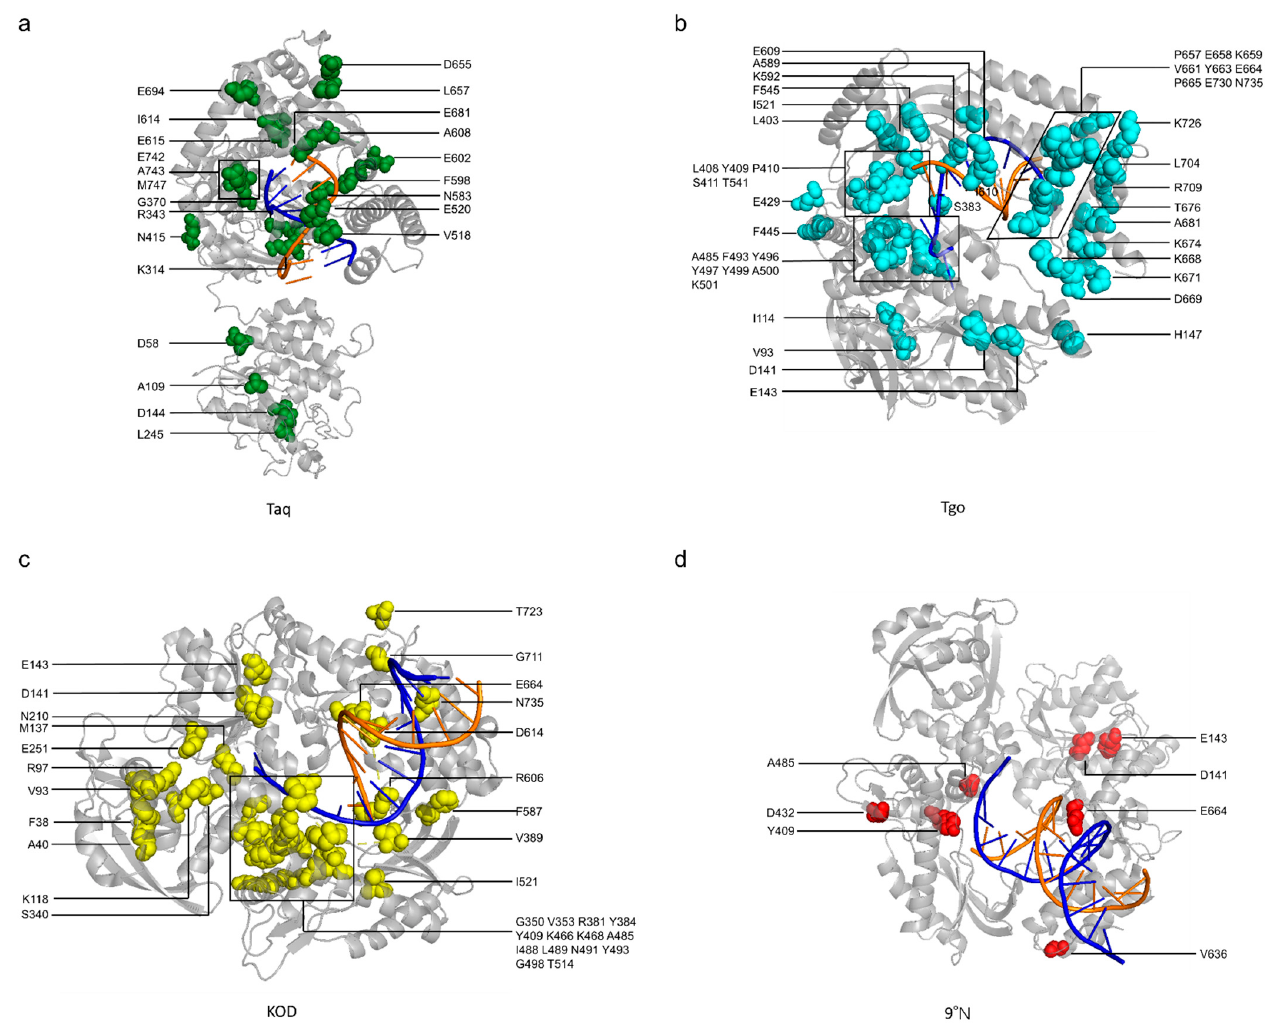
Figure 5. Distribution of the mutation sites in the engineered XNAPs. The mutation sites in engi- neered ( a ) Taq DNAP (green, PDB: 1TAU); ( b ) Tgo DNAP (cyan, PDB: 7B07); ( c ) KOD DNAP (yellow, PDB: 4K8Z); and ( d ) 9 ˚ N DNAP (red, PDB: 6ISF). The DNA templates and DNA primers are shown in blue and orange, respectively.